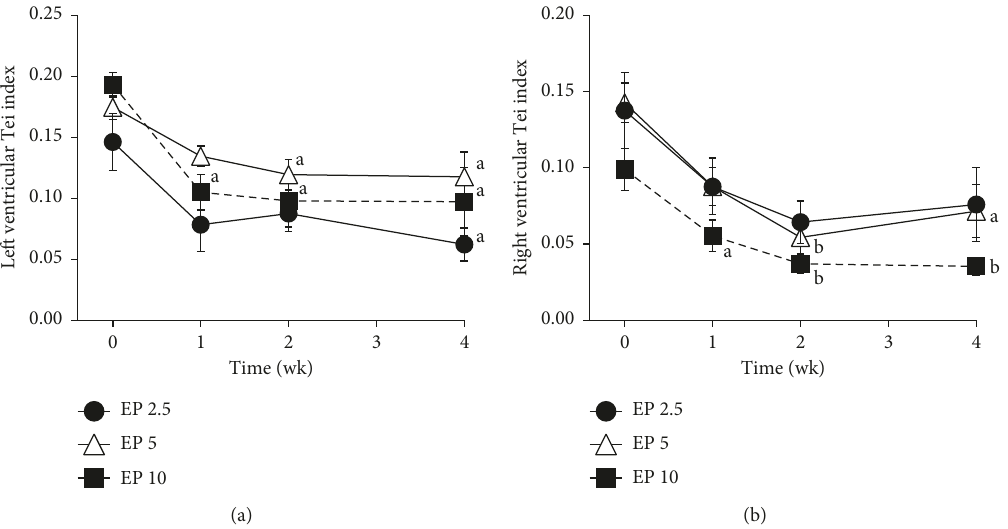
Figure 2: Left (a) and right (b) ventricular Tei indices after eplerenone (EP) administration in dogs. EP 2.5, 5, and 10: eplerenone 2.5, 5, and 10mg/kg, respectively. Each time point and vertical bar represent the mean and standard error ( n � 5). The lowercase letters indicate a significant difference from baseline (0) value (a— P < 0 . 05; b— P < 0 .